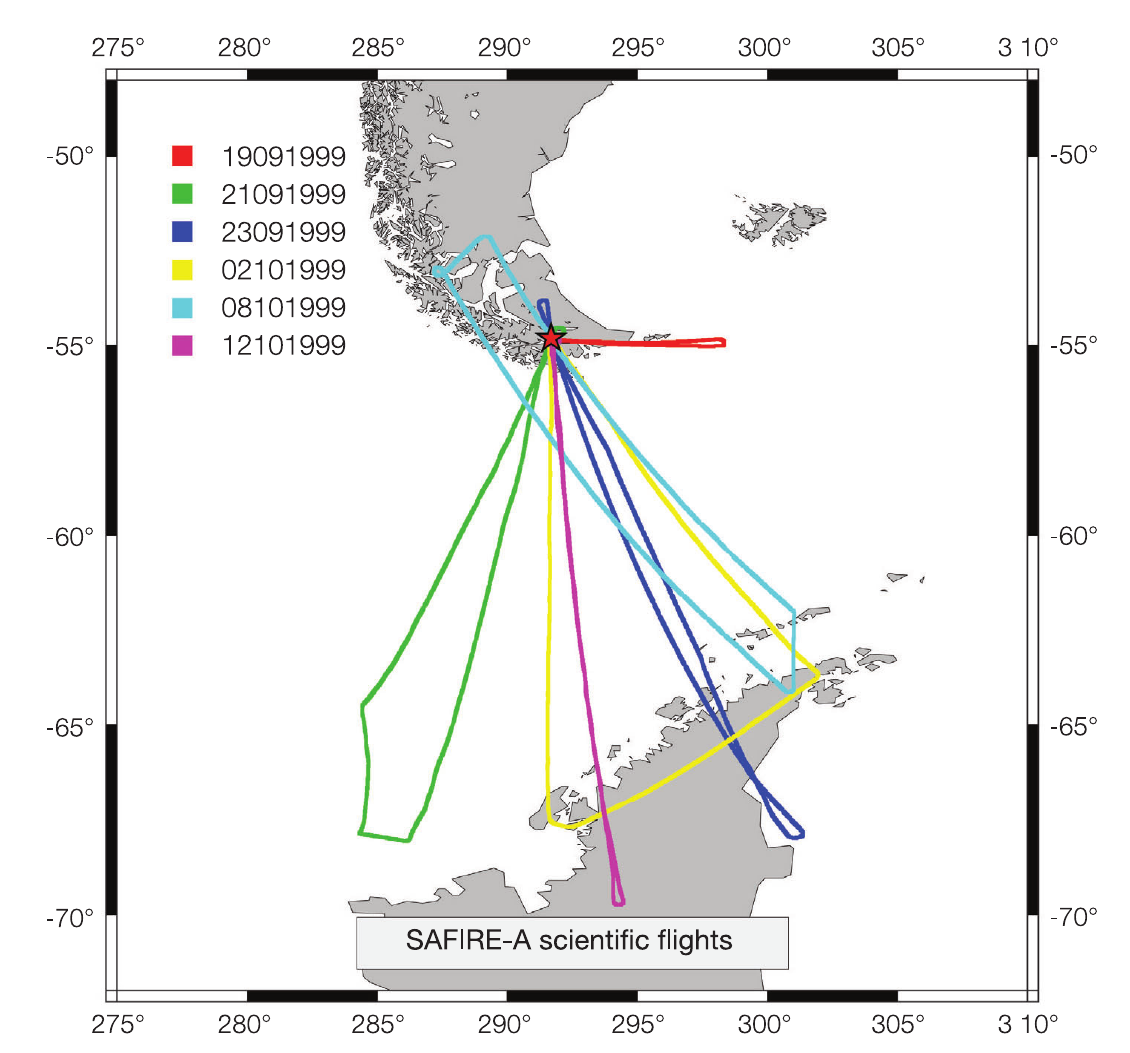
Fig. 13. Map of the APE-GAIA scientifi c fl ights